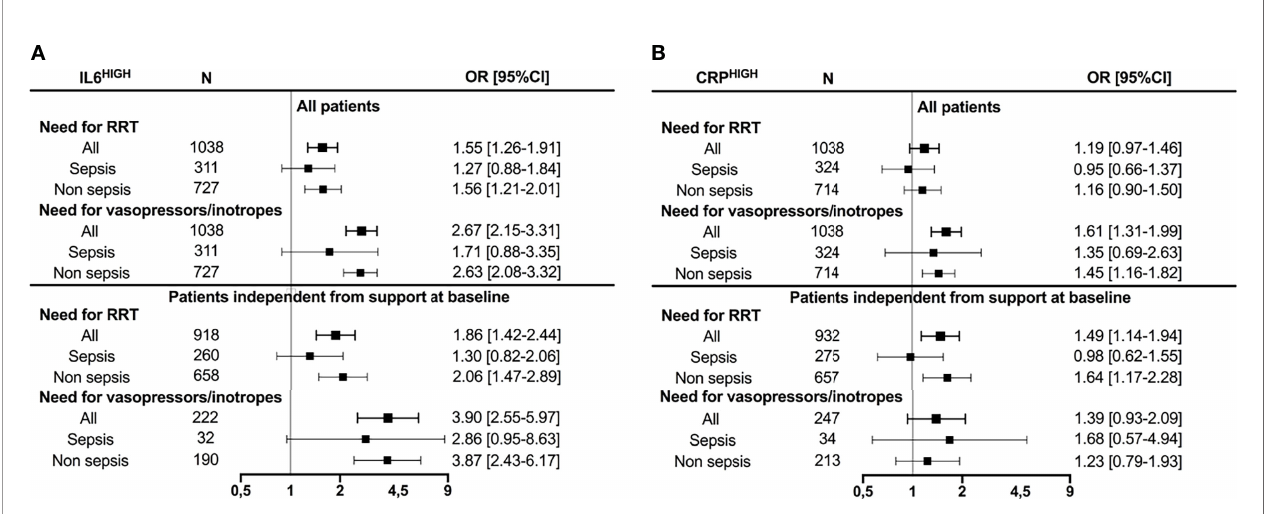
FIGURE 3 | Associations between IL-6 (A) or CRP (B) and the need for organ support. IL-6 HIGH and CRP HIGH are de fi ned as patients with biomarker over the respective median value. ORs for the need for RRT or vasopressors/inotropes are given for the IL-6 HIGH group taking the IL-6 LOW group as the reference risk (A) , for the CRP HIGH group taking the CRP LOW group as the reference risk (B) , in the whole cohort, as well as in patients independent from the given support at baseline. OR, Odds ratio; CI, Con fi dence interval; RRT, Renal replacement